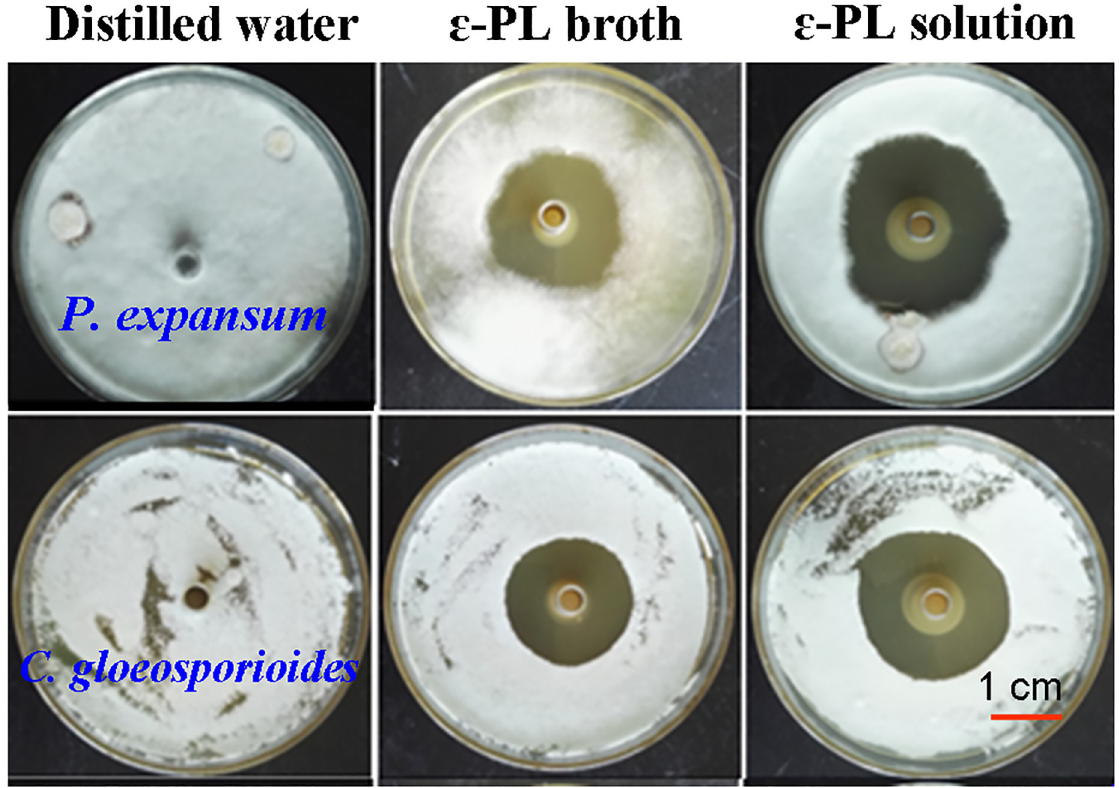
Fig 1. The growth of P . expansum and C . gloeosporioides in response to the broth and ε -PL solution in the PDA plates. ε -PL concentration was 200 mg/L in both solutions.